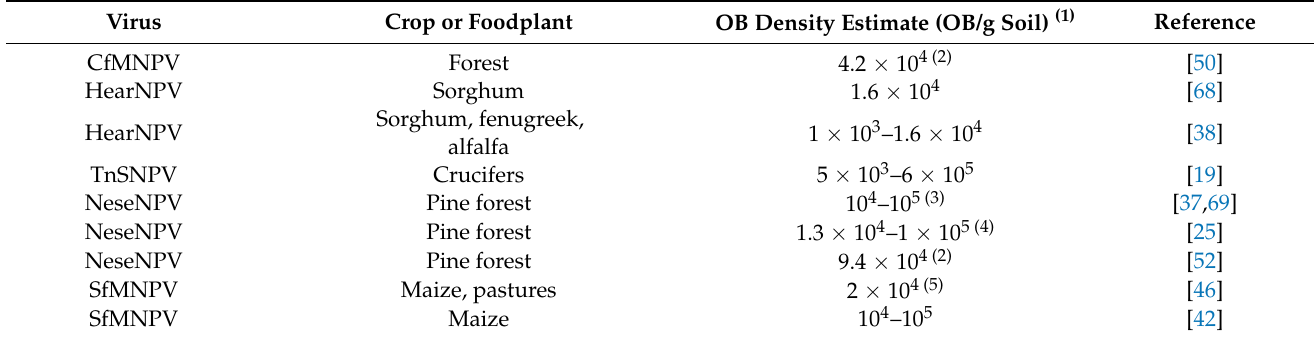
Table 2. Estimates of natural OB populations in untreated soil. Virus Crop or